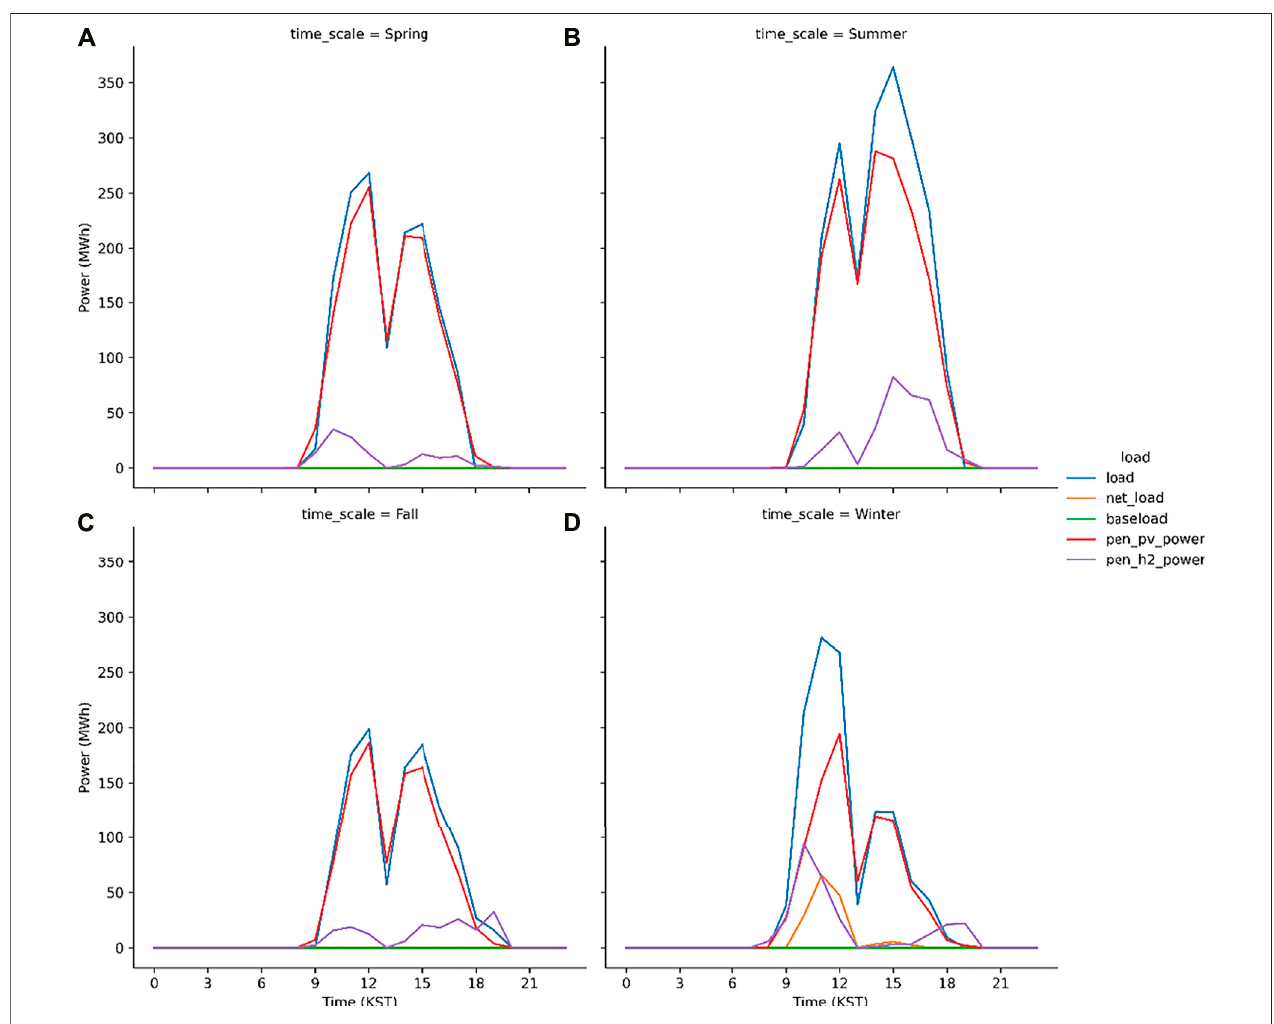
FIGURE 10 | Same as Figure 9 but in